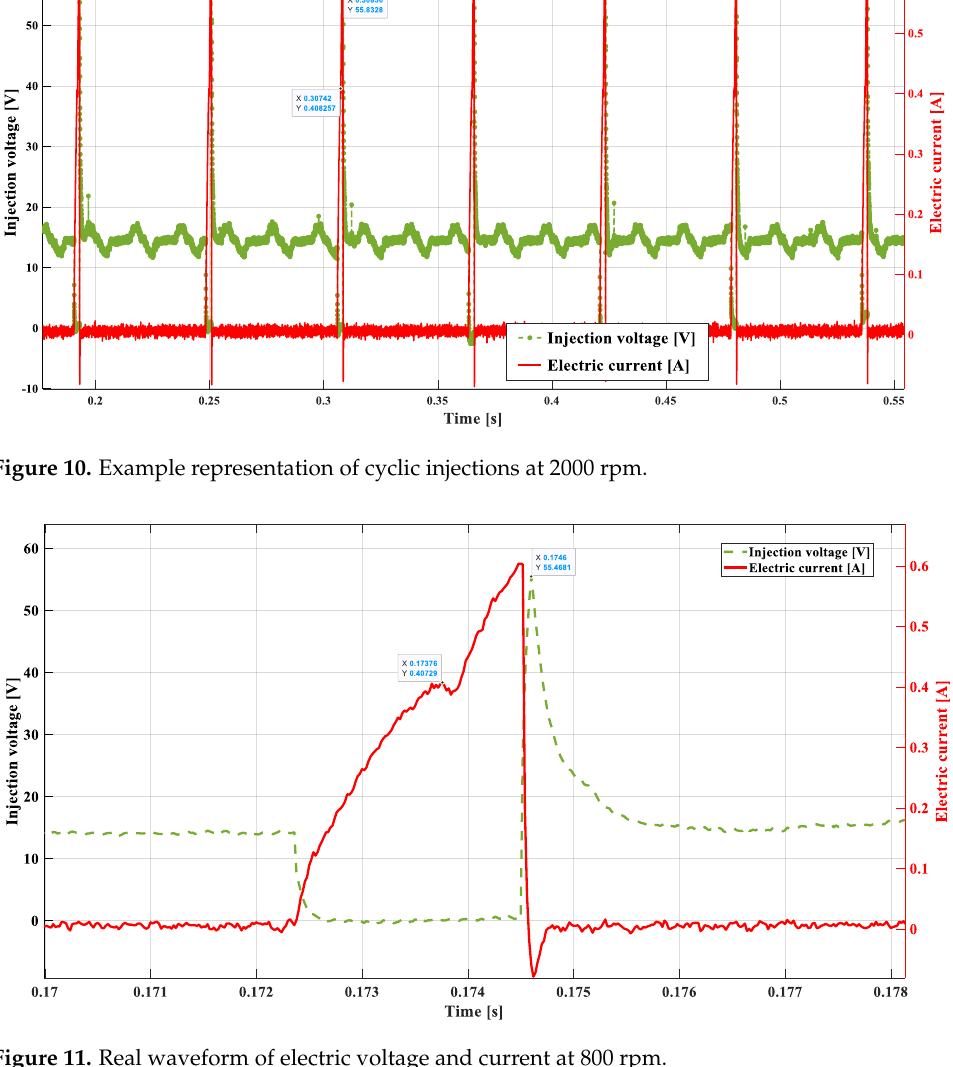
Figure 12. Voltage and current waveform. Resistance 10 Ω, 800 rpm.